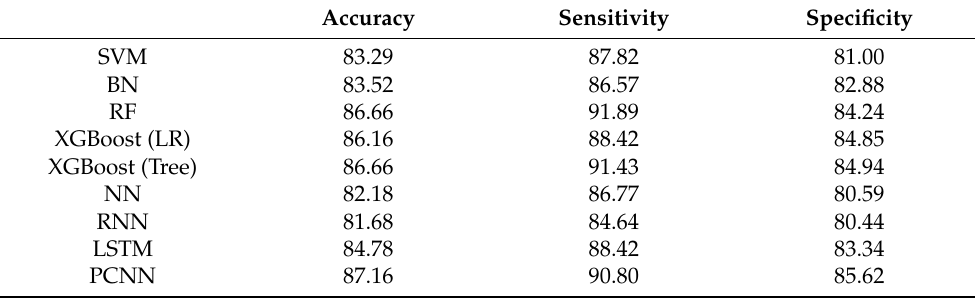
Table 5. Performance measures (10-fold cross-validation). SVM, support vector machine; BN, Bayesian network; RF, random forest; NN, neural network; RNN, recurrent neural network; LSTM, long short-term memory; PCNN, partial correlation neural